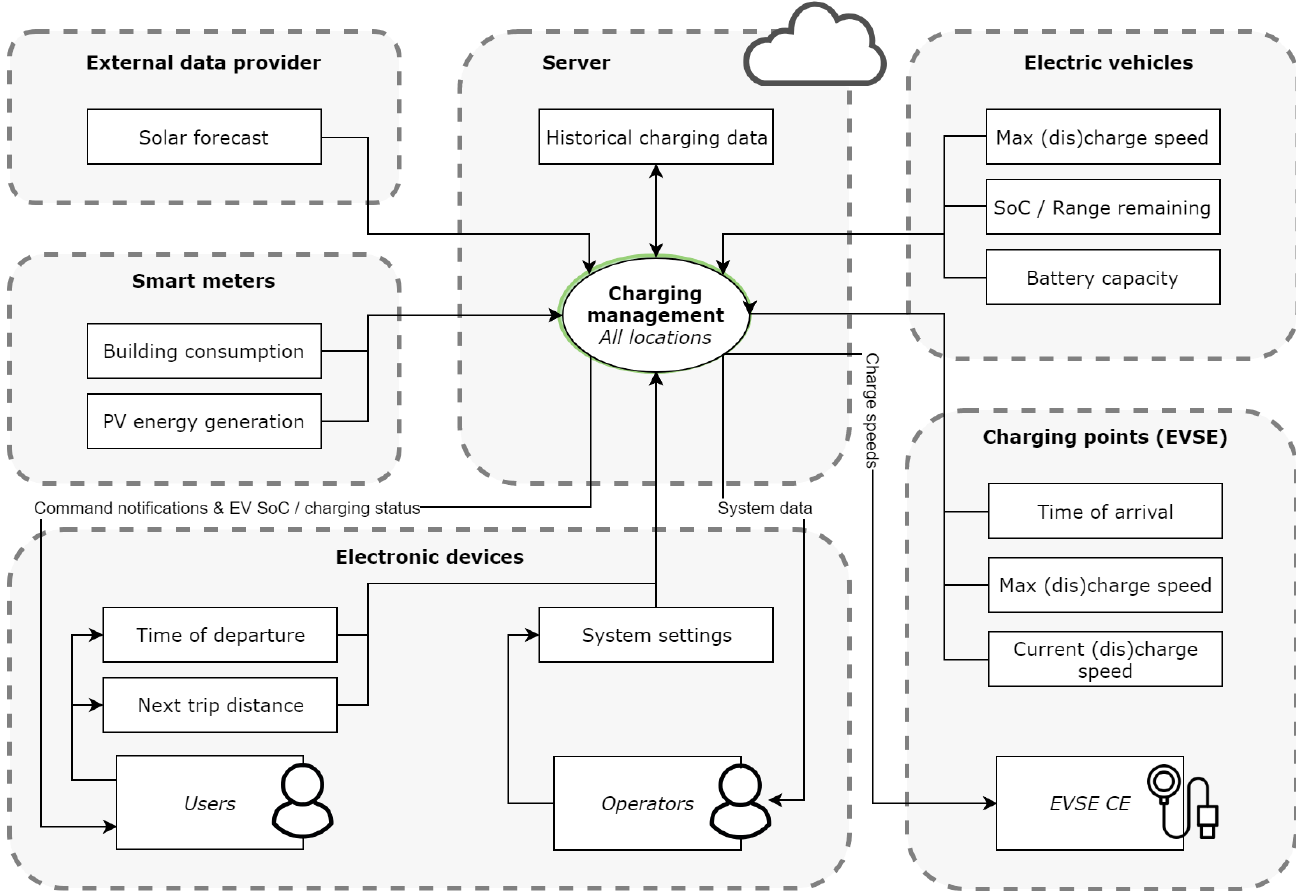
Figure 15. Function allocation to different parts of the future system. The back office manages the database and runs on a